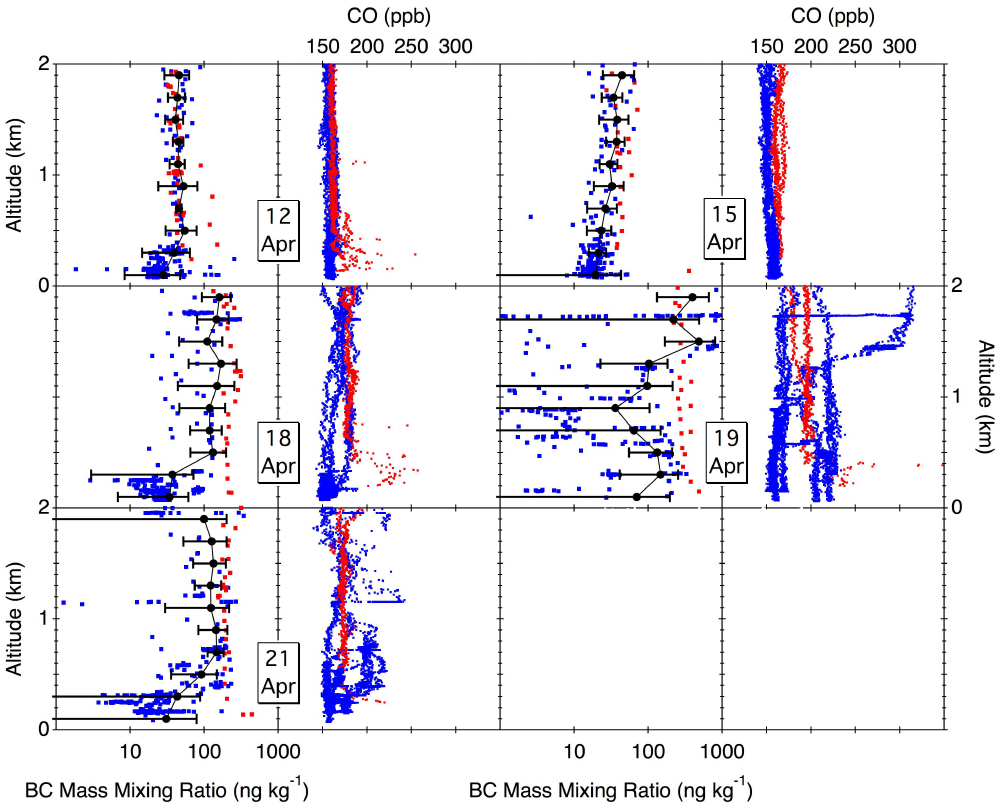
Fig. 3. Vertical profiles of BC mass loadings and CO in the lowest 2km altitude for all the flights during ARCPAC. The BC and CO data points are 30s and 1s data, respectively. The blue points denote BC data over the ice and open leads north of Alaska and the red points correspond to ascent/descent data at Fairbanks. The black lines with bars represent the mean BC profiles including the Fairbanks data with one standard deviation around the mean in each 200m altitude